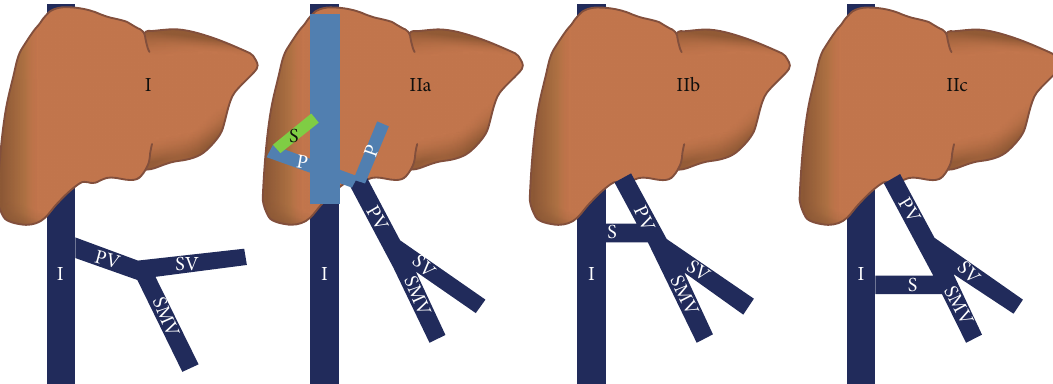
Figure 1: Schematic diagram showing various types of CEPS. I: IVC, P: portal vein branches, PV: portal vein, S: shunt, SMV: superior mesenteric vein, and SV: splenic